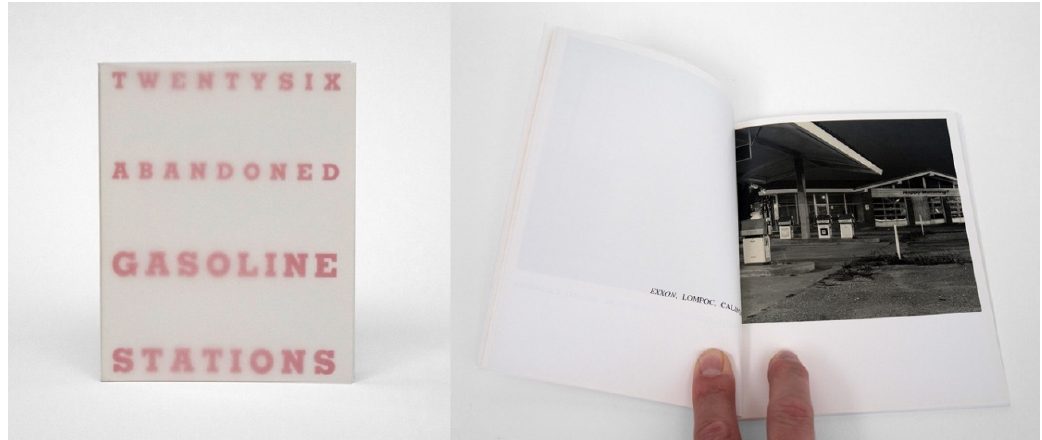
Figure 13. Je ff Brouws, Twentysix Abandoned Gasoline Stations, 1992. Figure 13. Jeff Brouws, Twentysix Abandoned Gasoline Stations , 1992.